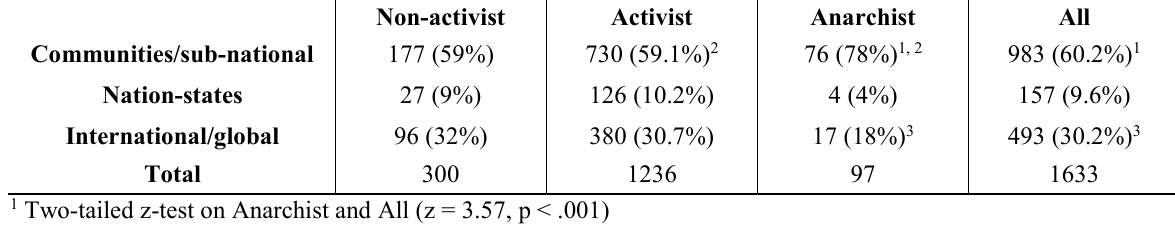
Table 8: Best Level for Solving Problems